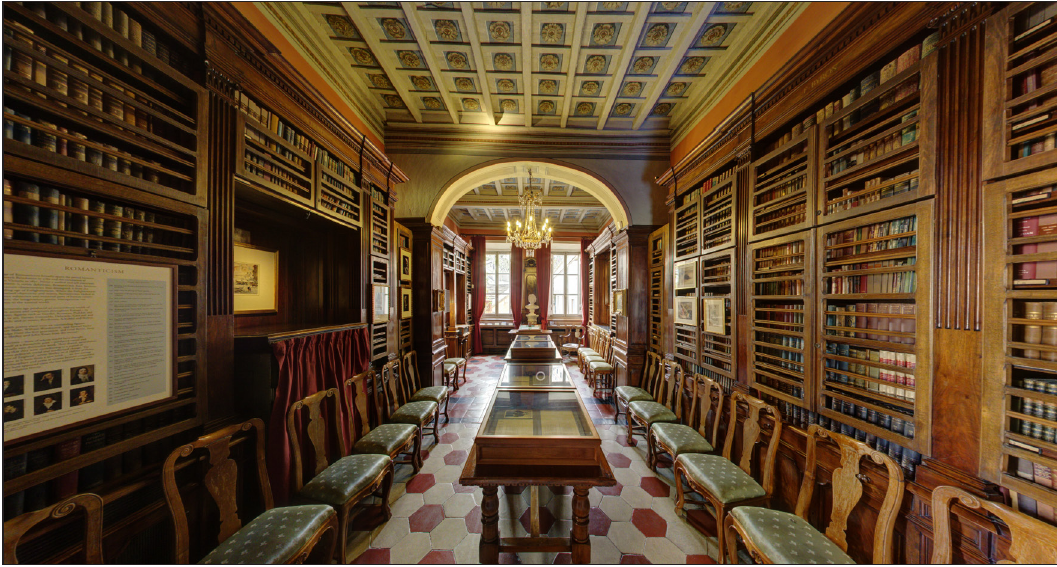
Fig. 4 : The Salone of the Keats-Shelley House, photographed from ‘A Panoramic Tour of the Keats-Shelley House’ created by